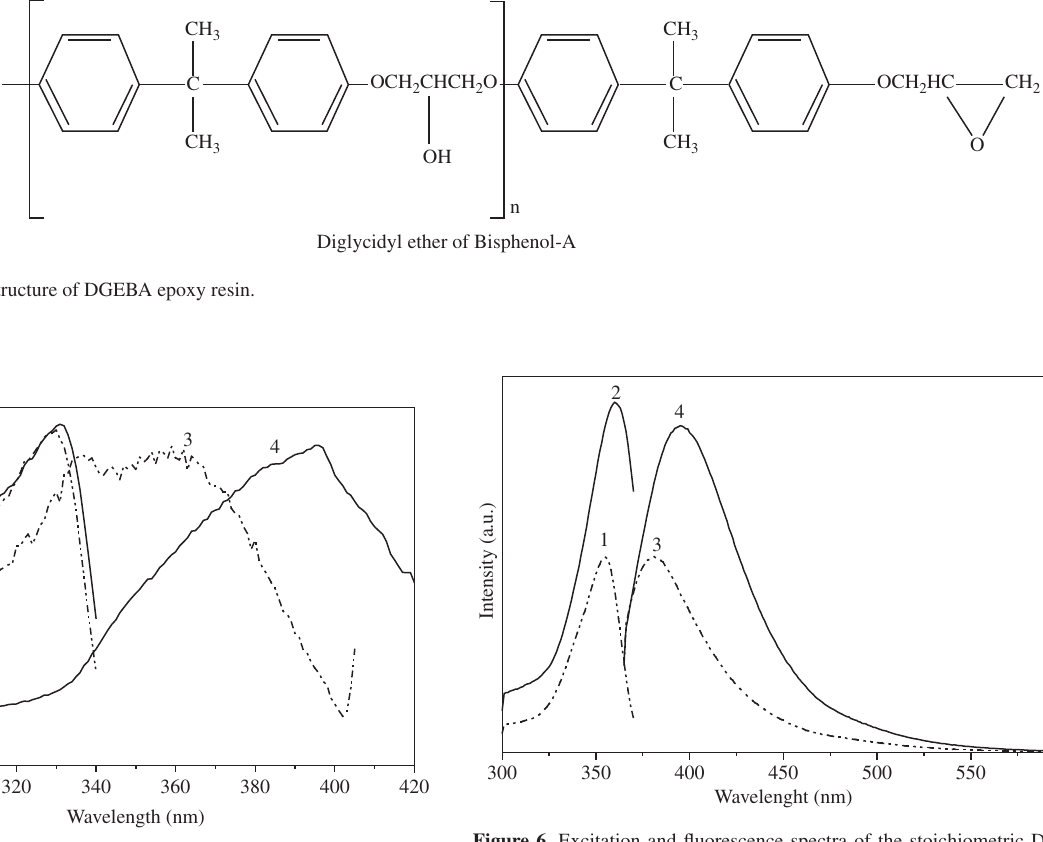
Figure 4. Excitation spectra of the stoichiometric DGEBA/DDM mixture (100:27 m/m) monitored at: 1) and 2) 350 nm; 3) 415 nm and 4) 452 nm. Dashed lines refer to DGEBA/DDM mixture before heat-treating; full lines correspond to the DGEBA/DDM mixture after heat-treating at 120 °C for 2 h (5 °C/min heating rate).